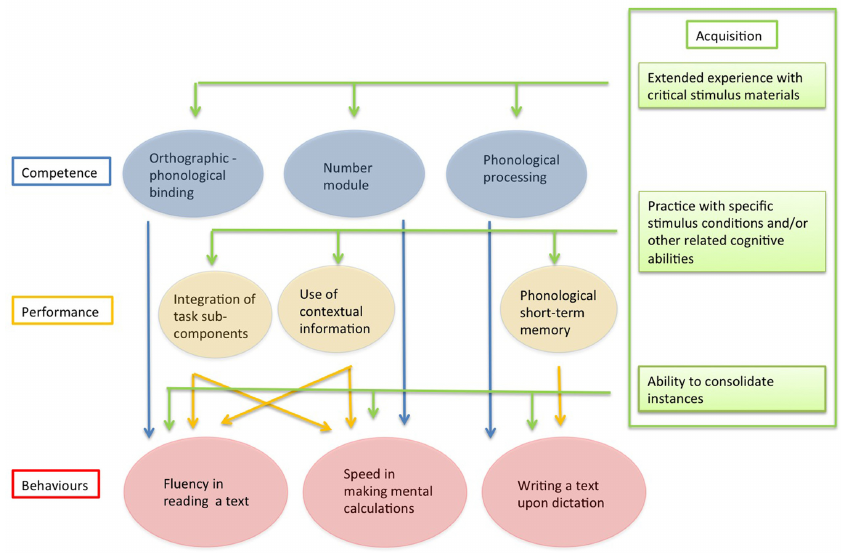
Figure 1. A multi-level model of learning skills [11].